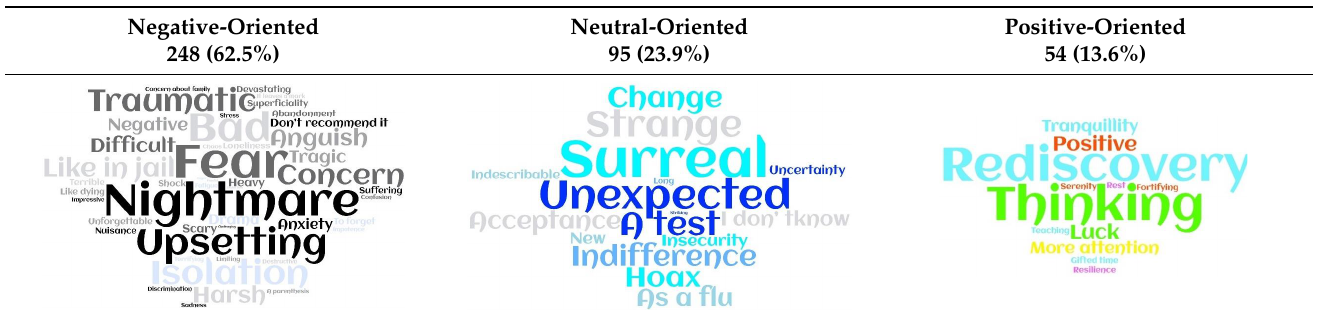
Table 2. ‘My lived experience as a COVID-19 survived patient’: metaphors and their